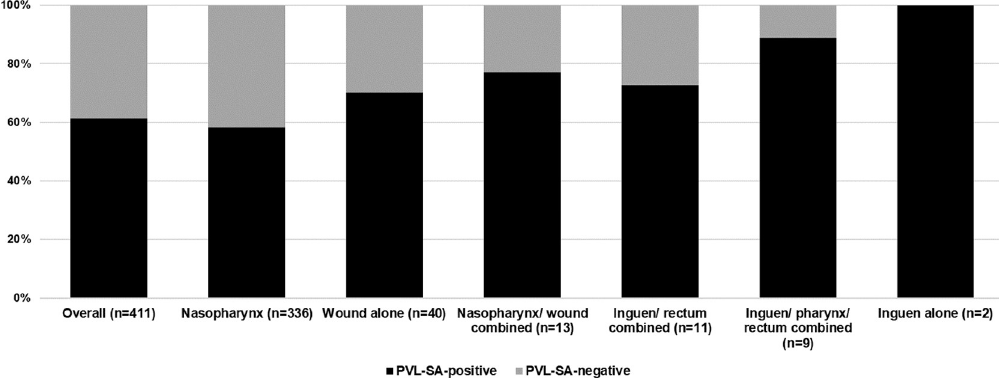
Fig 3. PVL-SA examination sites and associated detection rate. PVL-SA-positive, Panton-Valentine leukocidin Staphylococcus aureus positive. PVL-SA-negative, Panton-Valentine leukocidin Staphylococcus aureus negative. Pharyngeal, nasopharyngeal swab either combined or alone.